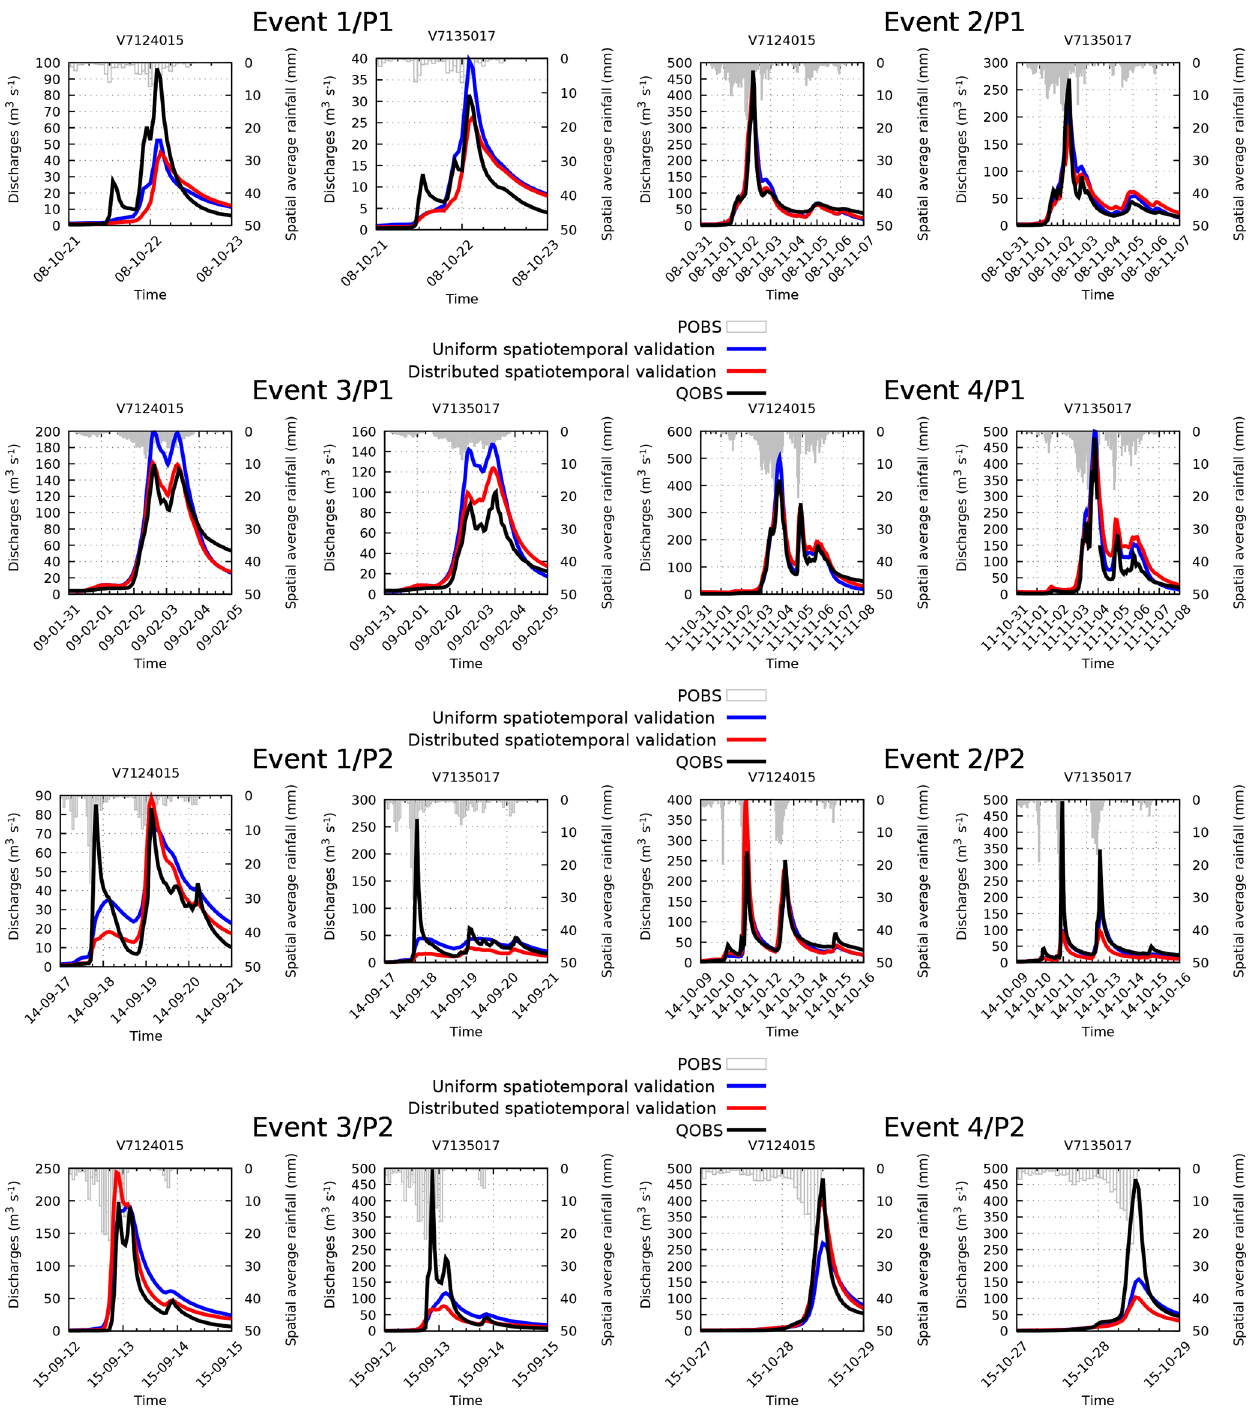
Figure 5. Spatiotemporal predicted discharges (with the distributed and uniform set of parameters) and observed discharges during the height major events issued from period P 1 and P 2 at stations V7124015 and V7135017. Please note that the date format in this figure is two-digit year-month-day. QOBS: observed Q ; POBS: observed P